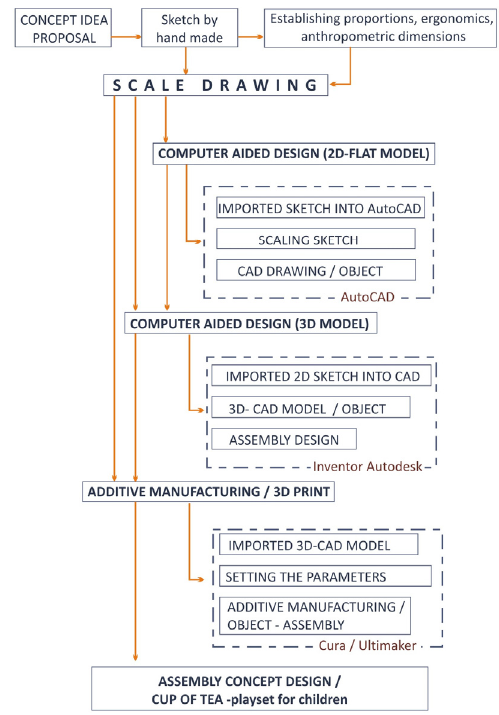
Figure 1. Systemic analysis block scheme.